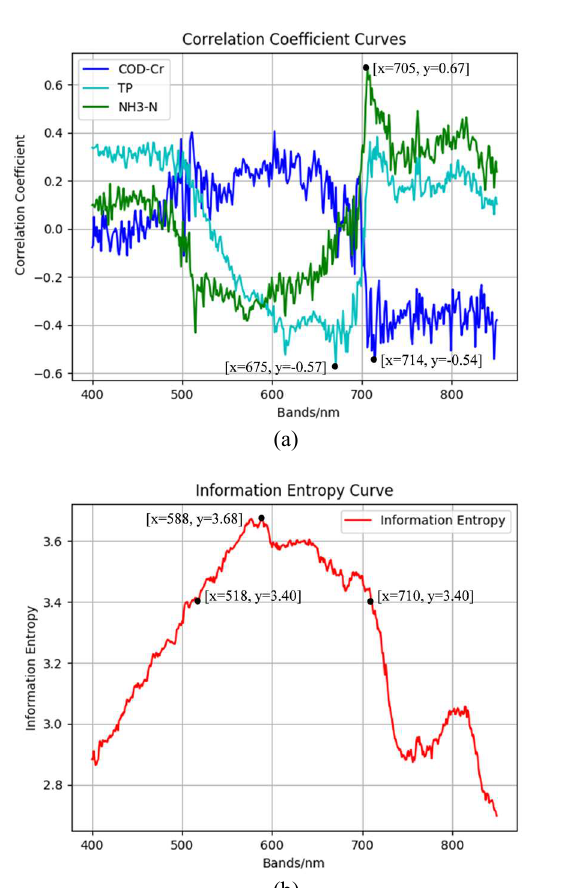
Figure 2. Correlation coefficient curves of water samples and spectrum information entropy curve (a) Correlation coefficient curves (b) Information entropy curve